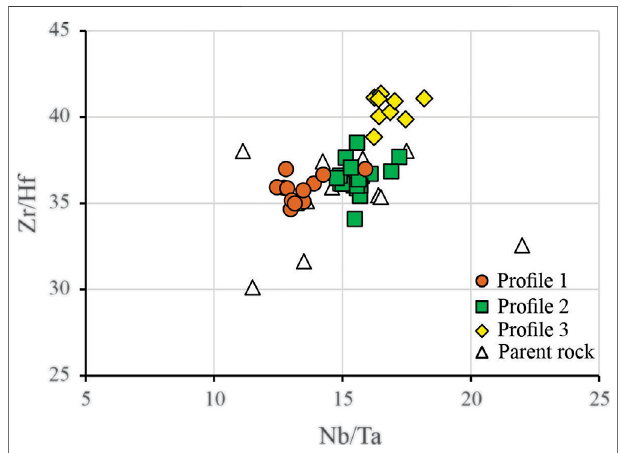
FIGURE 3 | Plot of Zr/Hf vs . Nb/Ta ratios of the bulk samples showing the range among the parent rock and the horizons of pro fi les 1 and